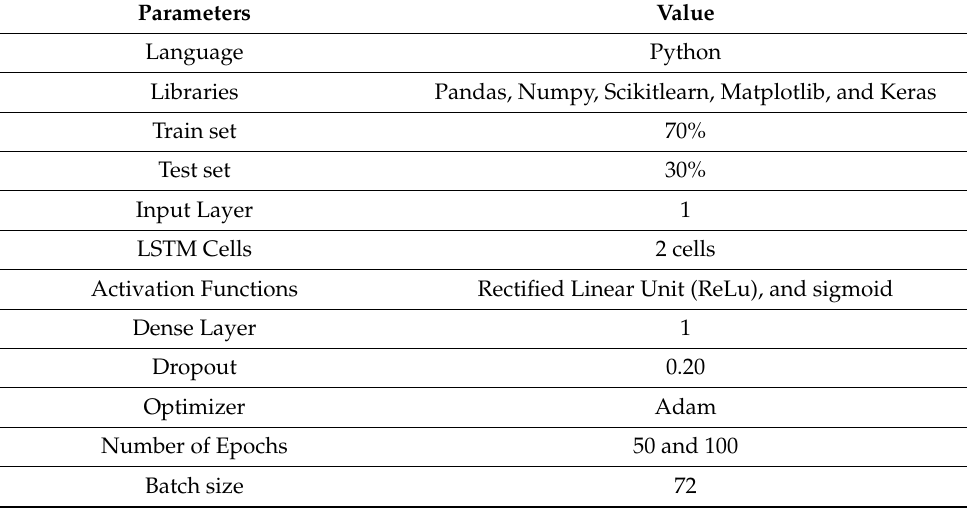
Table 5. Model setup settings.